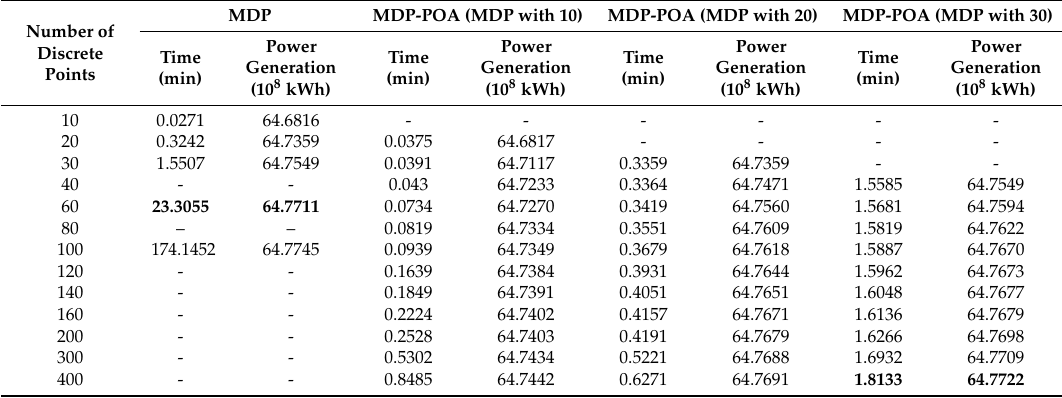
Table 3. Detailed calculation results of MDP and MDP-POA in the dry